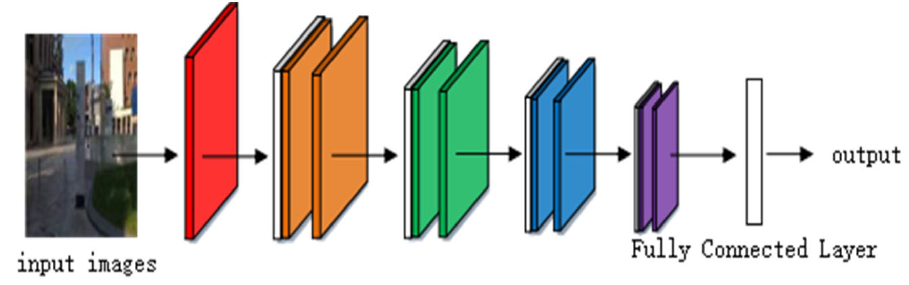
two are equivalent.